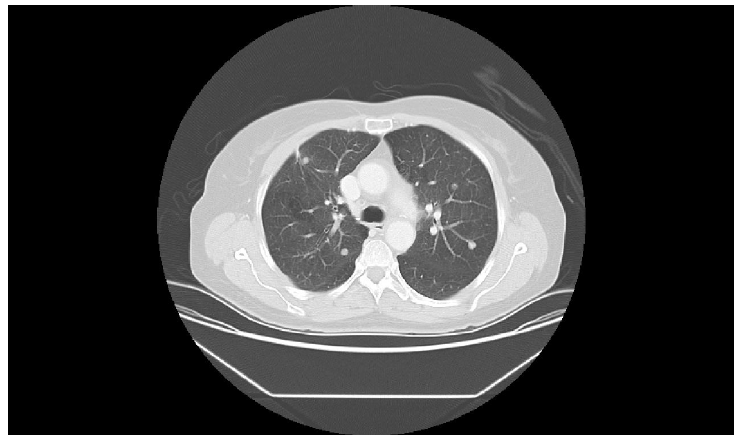
FIGURE 1 . Multiple nodular densities in the lung fields of a 62-year- old lady. Features are not specific, but highly suggestive of